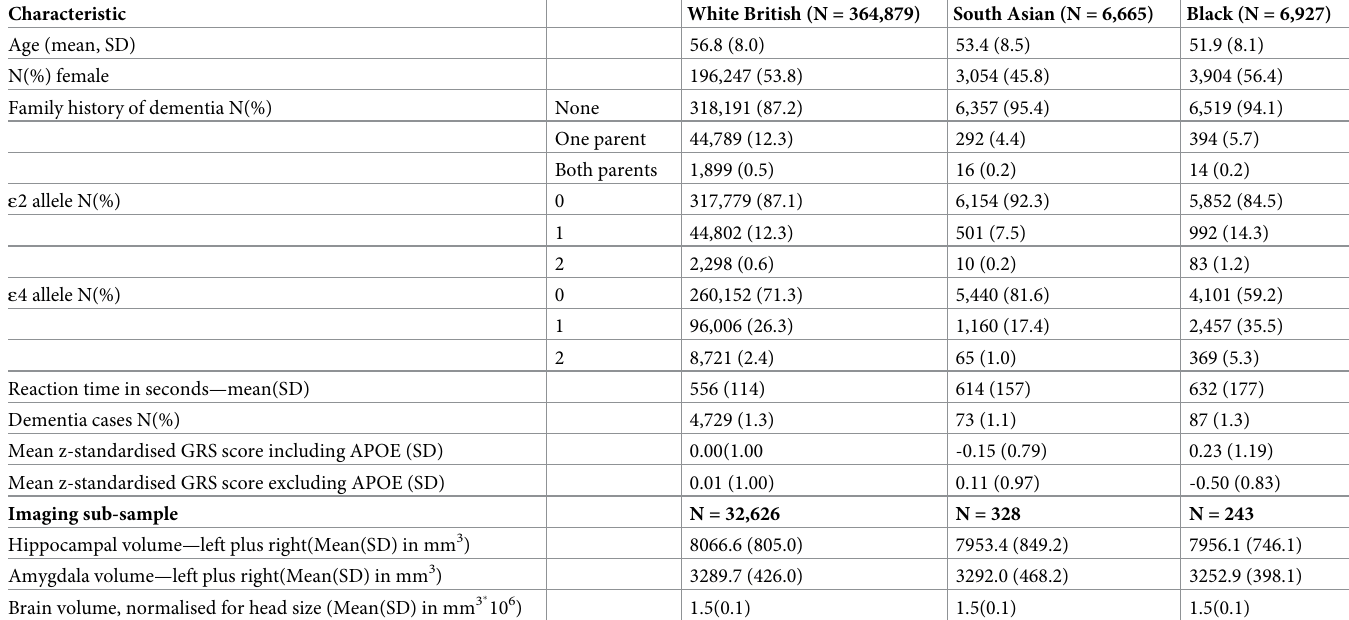
Table 1. Characteristics of included participants by self-defined